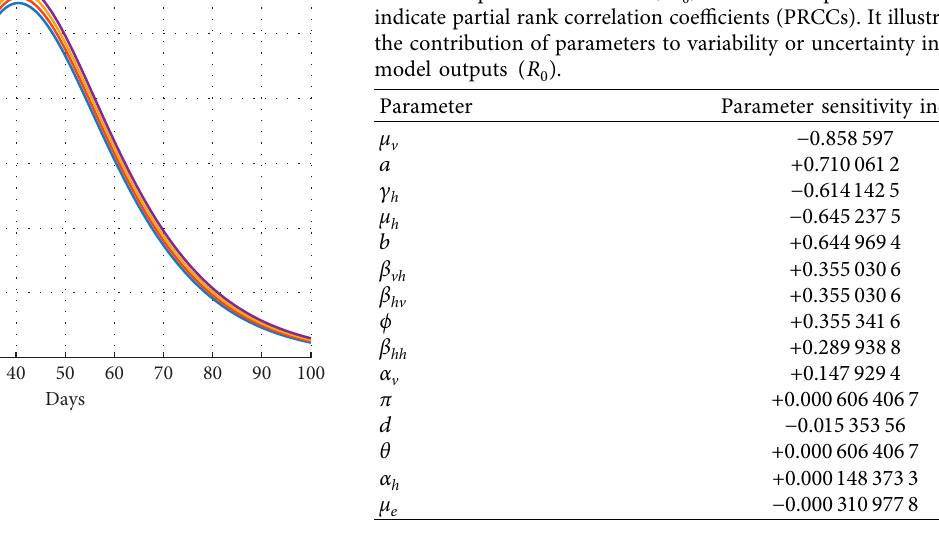
Figure 9: Evolution of the epidemic spreading in the vector population for various values of the vertical transmission rate π . Mosquito-to-human interaction is set at a � 0 . 2.